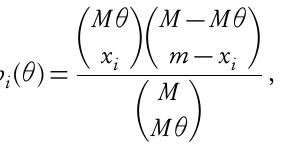
the mean, the variance, the skewness, and the kurtosis of all the corresponding power ( θ , α ) } , along α > negative binomial distributions { r i